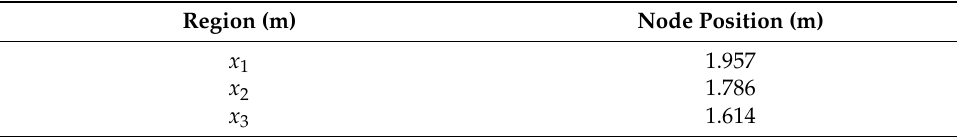
Table 2. The positions of the electric-field integral nodes during the